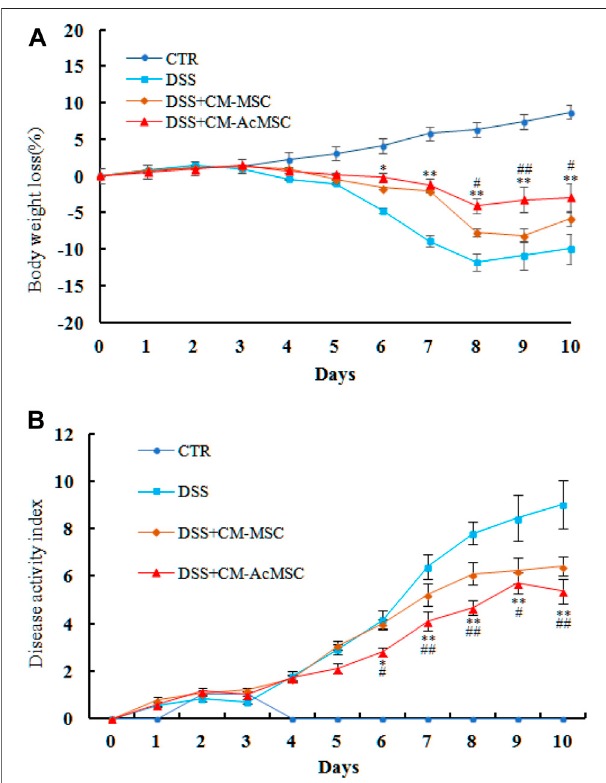
FIGURE 2 | CM-AcMSC effectively alleviated the body weight loss and DAIof DSS induced colitis model rats, n (cid:2) 15. (A) Body weight was measured daily (DSS vs DSS + CM-Ac-MSC, * p < 0.05, ** p < 0.01; DSS + CM-MSC vs DSS + CM-Ac-MSC, # p < 0.05, ## p < 0.01). (B) DAI was measured duringthediseaseprocess(DSS vs DSS+CM-Ac-MSC,* p < 0.05, ** p < 0.01; DSS + CM-MSC vs DSS + CM-Ac-MSC, # p < 0.05, ## p <